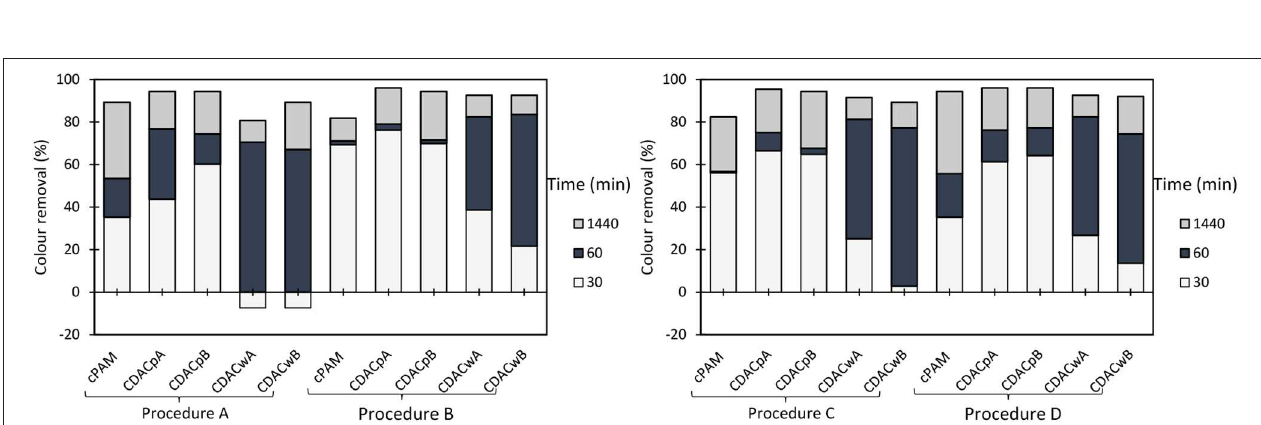
FIGURE 3 | Turbidity removal of industrial effluent as a function of time of settling, using cationic cellulose-based flocculation agents from bleached pulp (CDAC p A and B) and from wood chips (CDAC w A and B), in a dual system with bentonite, at pH 1.5. Procedure A: 0.3 wt% bentonite followed by 2.67 mg/L of flocculant. Procedure B: 0.6 wt% bentonite and 5.34 mg/L of flocculant. Procedure C: 0.3 wt% bentonite and 5.34 mg/L of flocculant. Procedure D: 0.6 wt% bentonite and 2.67 mg/L of flocculant. A cationic synthetic cPAM (in dual system with the same concentrations described in procedures A-D), was used as reference.